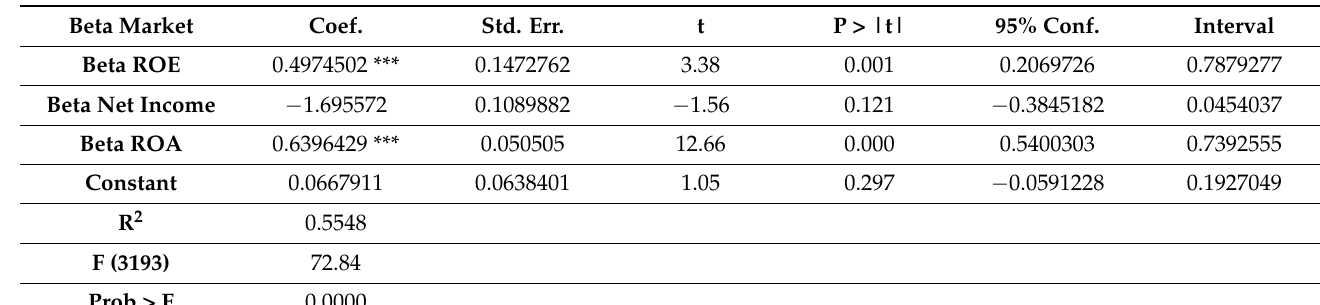
Table 5. Regression analysis.